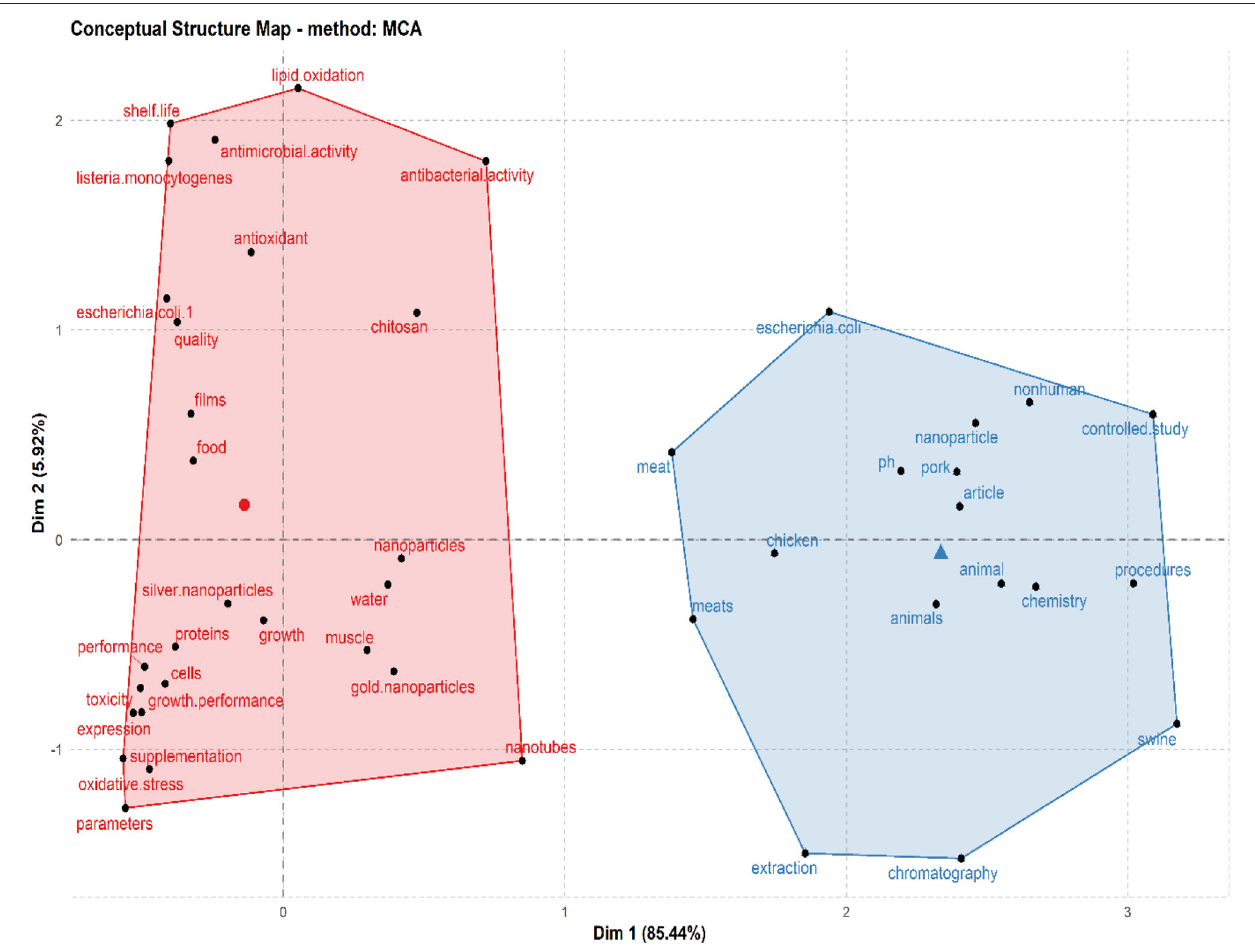
FIGURE 5 | Common conceptual frames related to meat production via the use of nanotechnology research studies. The 656 retrieved articles showed K-means clustering with two (2) clusters reflecting models of nanomaterials (nanotubes, silver nanoparticles, and gold nanoparticles) for improvement of meat (chicken and pork), meat qualities (ph, shelf-life, lipid oxidation, antioxidant, etc.), performance (growth, oxidative stress, muscle meat), and healthy meat (antibacterial activities e.g., listeria, Escherichia coli ) commonly linked to nanotechnology and meat